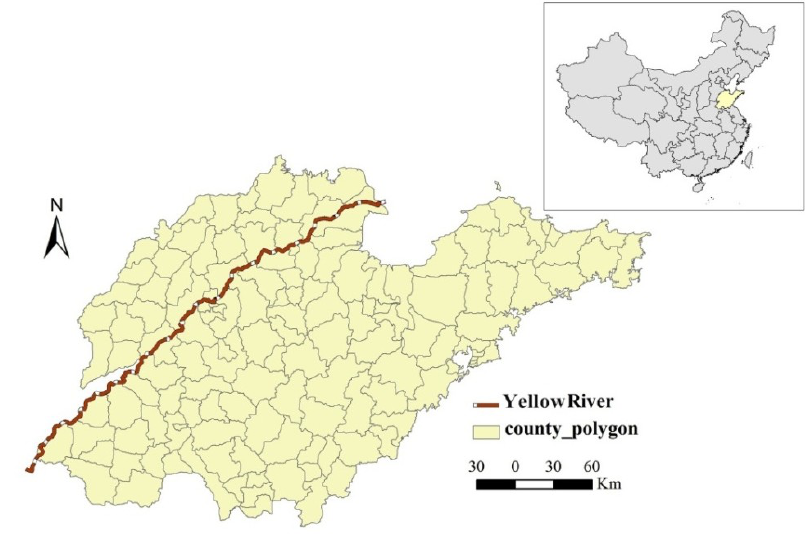
Figure 1. The location of study area — Shandong Province in